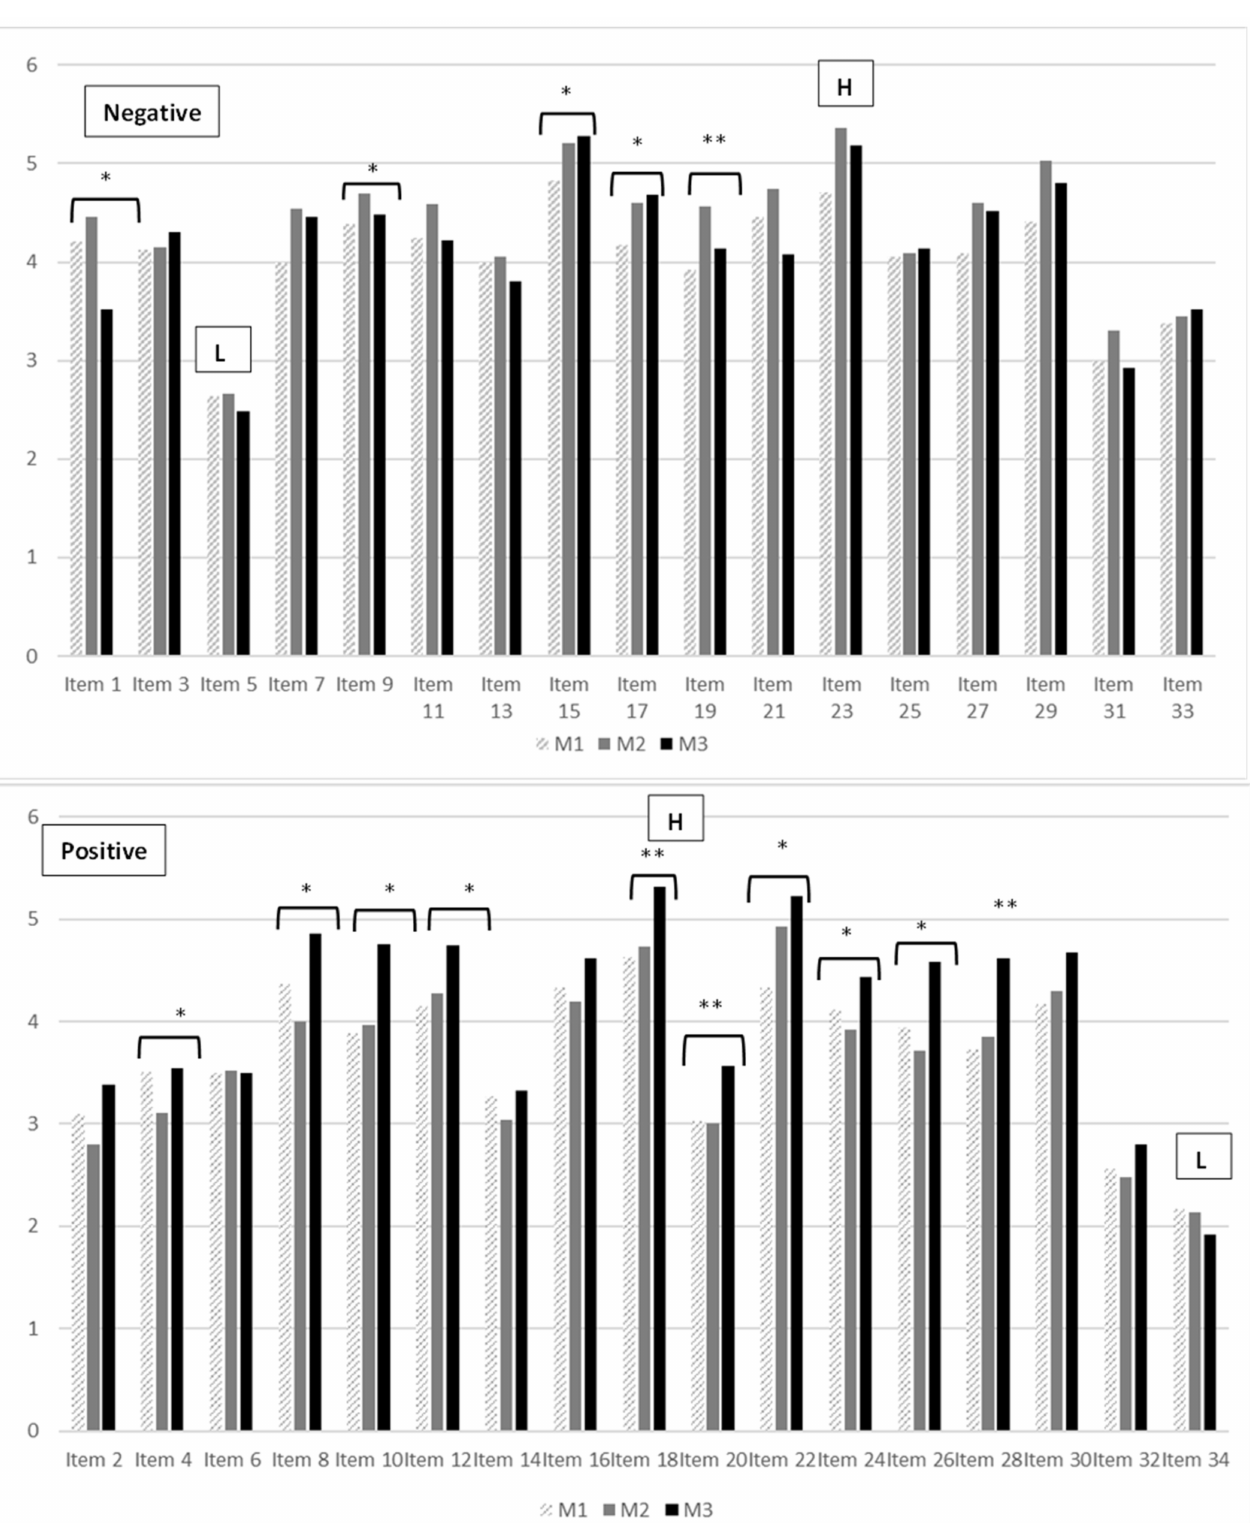
Figure 4. Negative and positive items score in Kogan’s scale throughout the study. H: highest scores, L: lowest scores; M1: Moment 1; M2: Moment 2; M3: Moment 3; * p < 0.05; ** p <